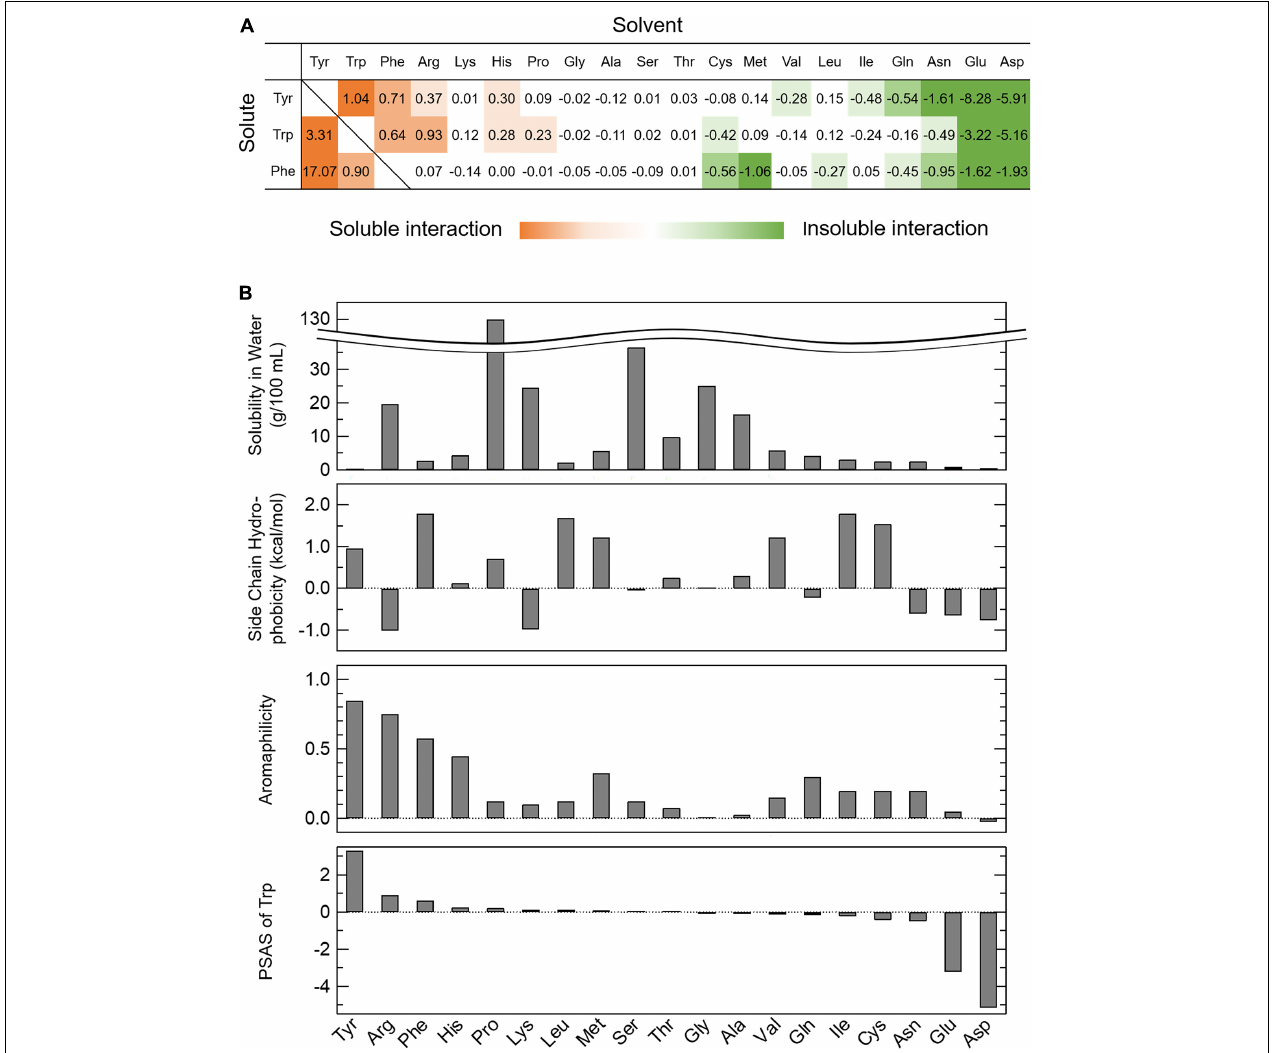
FIGURE 1 | Parameter of solubility of AAAs in amino acid solvents (PSAS). (A) The PSAS of AAAs in 20 kinds of amino acid solvents. The PSAS was calculated from Equation (1). The PSAS is shown as a positive value when the solubility of the AAAs increases and as a negative value when it decreases. (B) Relationships of the PSAS with the various indices characterizing amino acids. The PSAS of Trp is compared to the solubility in water, side chain hydrophobicity, and aromaphilicity of 20 kinds of amino